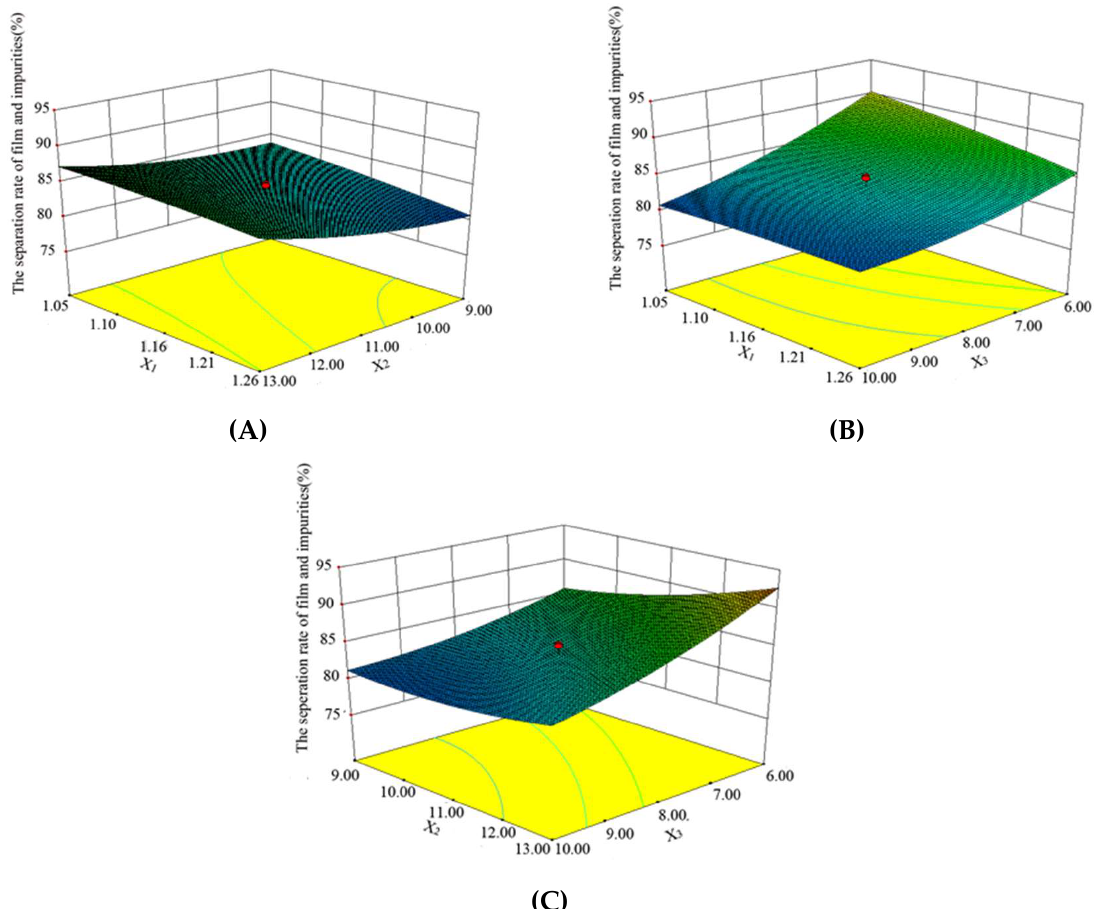
Figure 6. ( A ) The interaction between X 1 and X 2 . ( B ) The interaction between X 2 and X 3 . ( C ) The interaction between X 1 and X 3 .